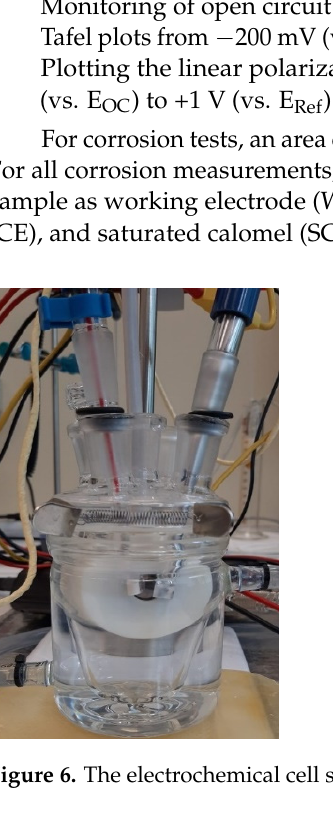
Figure 5. EDS spectra and elemental distribution for CCm samples.